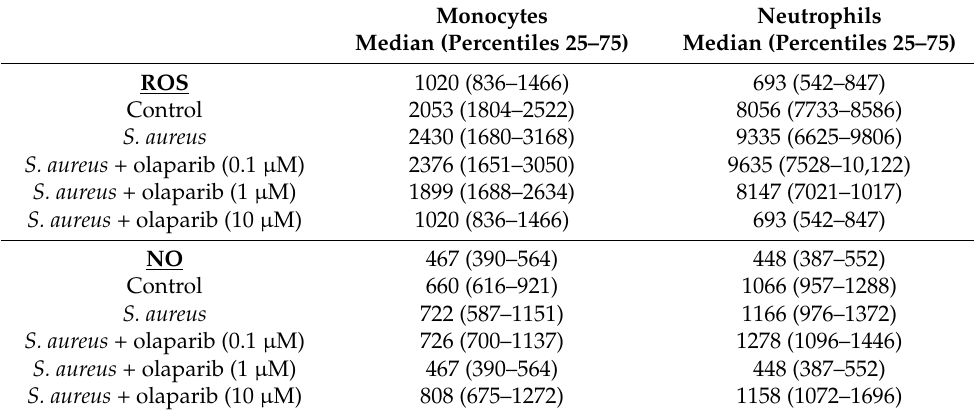
Table 1. Effect of olaparib on ROS and NO production in monocytes and neutrophils. Cells were obtained from healthy volunteers (N = 5), and the assay was conducted without stimulus (control) or after S. aureus in the presence of olaparib (0.1–10 µM). Data are shown as the geometric mean fluorescence intensity (GMFI) of DCFH and DAF for ROS and NO, respectively.